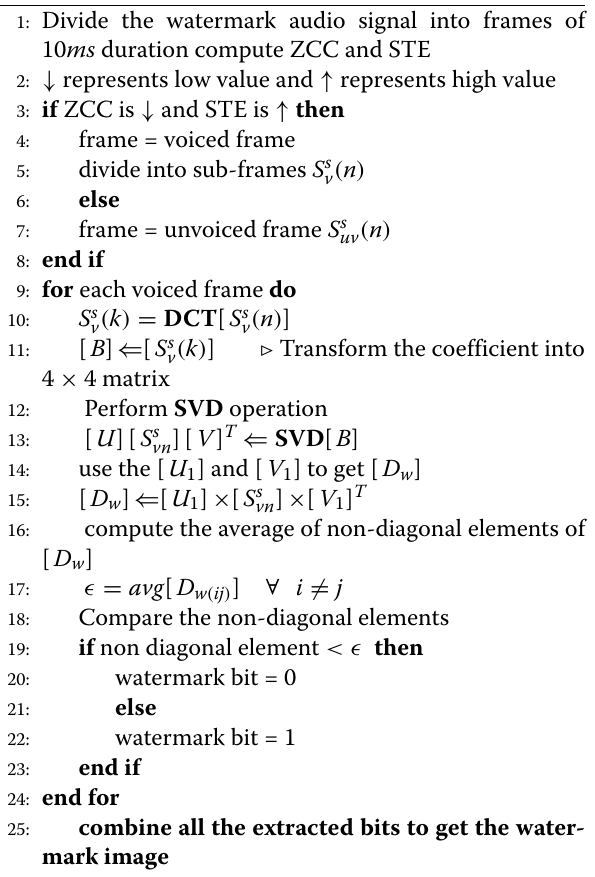
watermarked audio signal is divided into non-overlapping frames of L samples per frames and marked as voiced and unvoiced frames, as mentioned in Subsection 2.1. Each